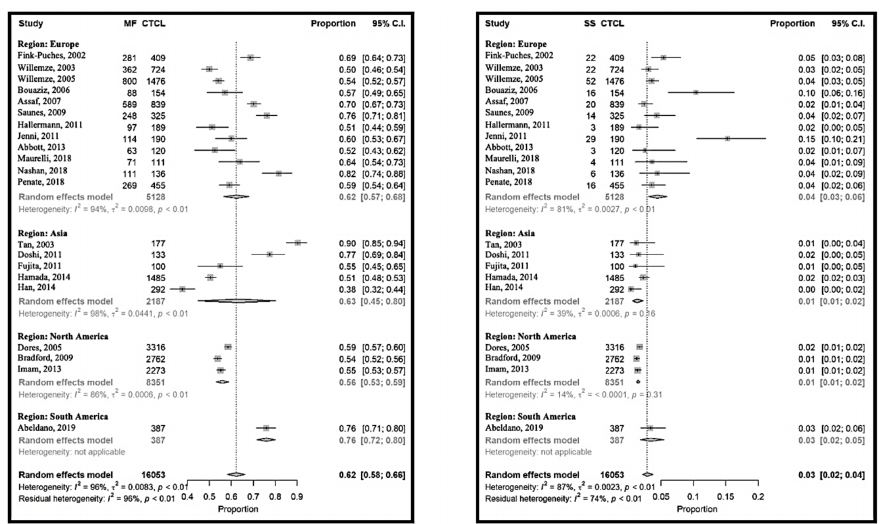
Figure 3. Meta-analyses of the proportion of mycosis fungoides (MF) and S é zary syndrome (SS) compared to